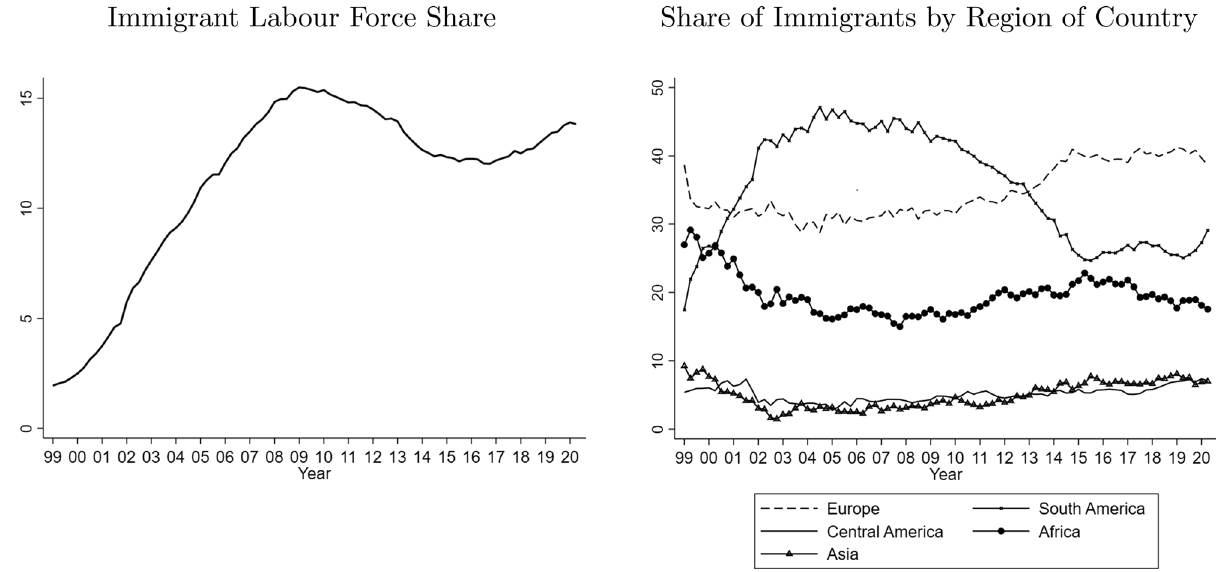
Figure 2: Immigrant share and composition by the region of country. Note: Share of foreign - born workers who are actively participating in the labour market. Source: Spanish Labour Force